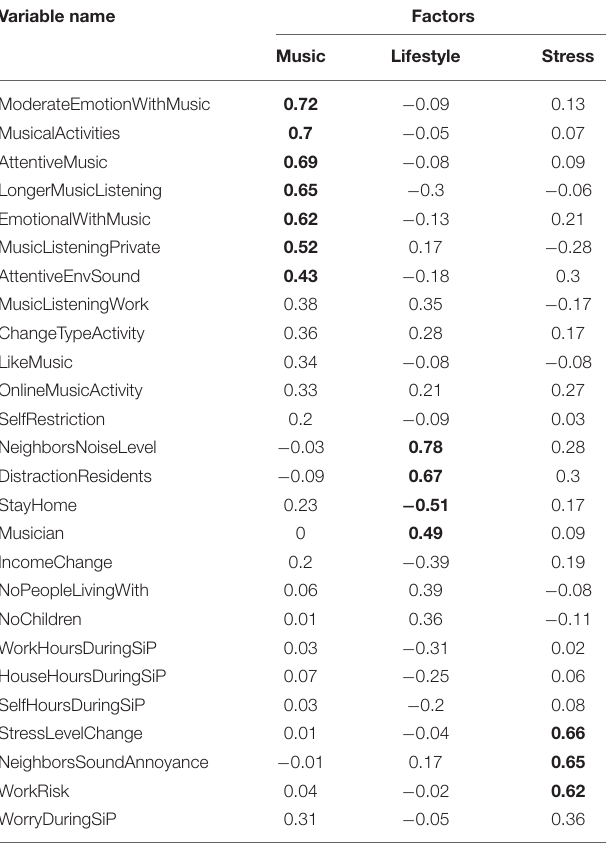
TABLE 8 | Results of factor analysis (number of factors =